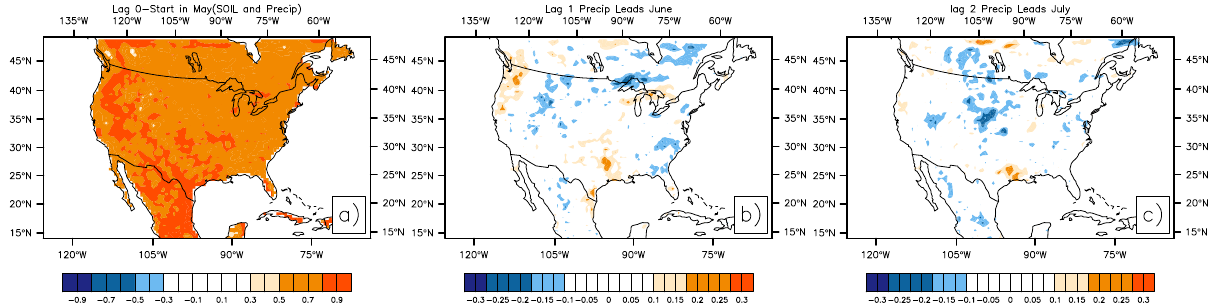
Fig. 11. Plots (a–c) show the correlation between soil moisture for the topmost layer in (mm) and precipitation (mmday − 1 ) for the NINO simulation only. Correlations are calculated with lag of zero (a) which represents the climatological average for May–August (soil moisture) versus May–August (precipitation). Plot (b) is precipitation lagging by one month, May–August (soil moisture) versus June–September (precipitation). Plot (c) is precipitation lagging by 2 months, May–August (soil moisture) versus July–November (precipitation). The data is plotted to incorporate only the statistically significant data at the 95% confidence